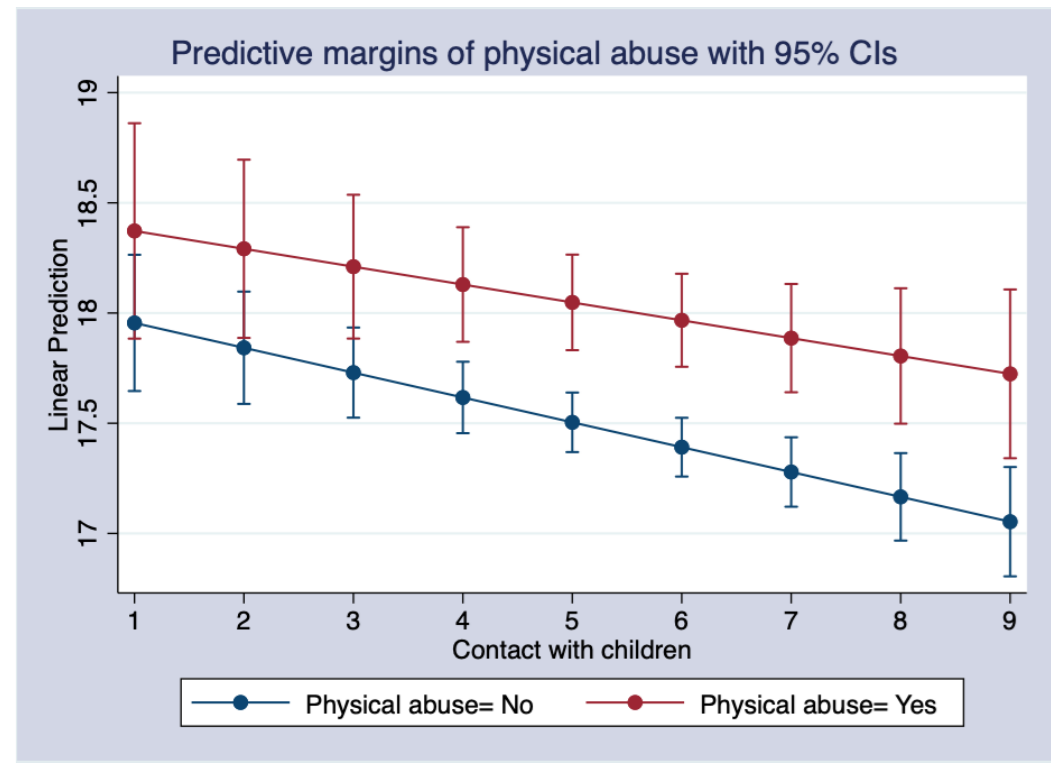
Figure 1. The marginal effects of contact with children on depression and physical abuse.